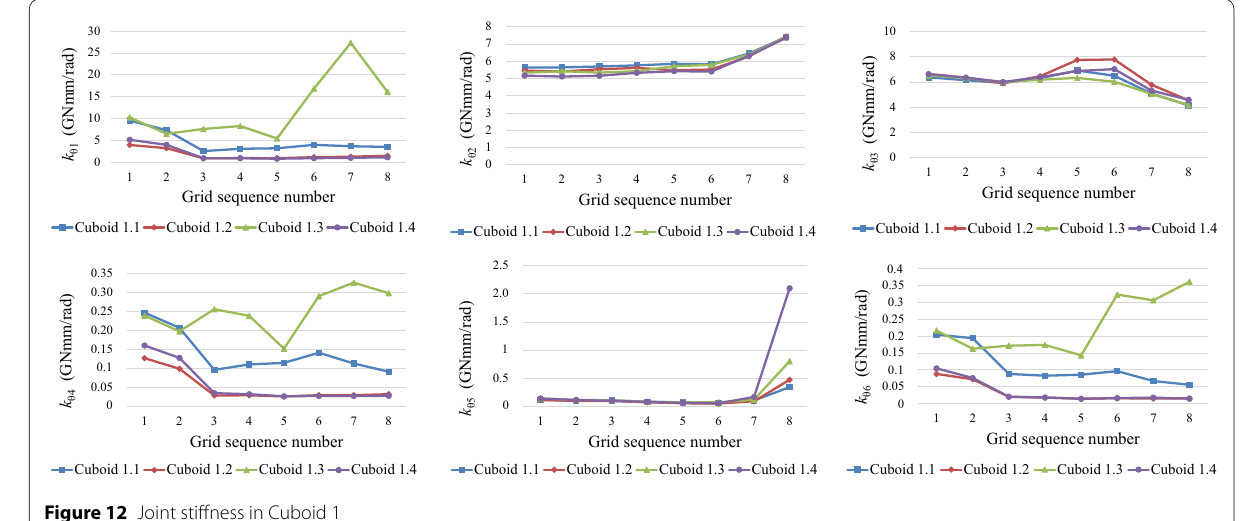
Figure 12 Joint stiffness in Cuboid 1